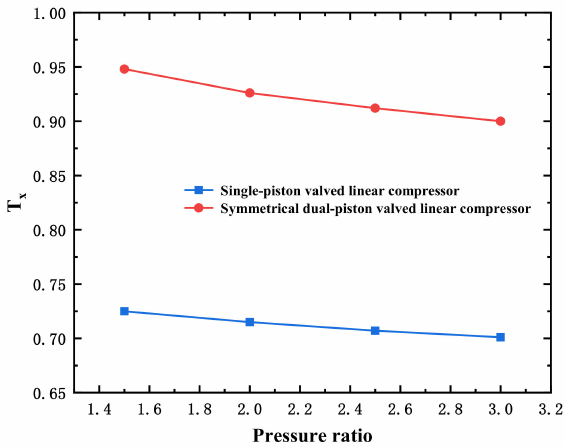
Figure 8. The same direction ratios of the two types of linear compressors under different pressure ratios.